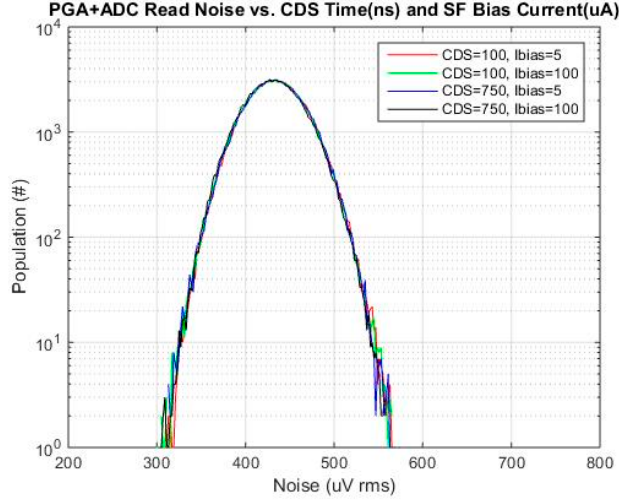
Figure 11. Base read noise histogram for selected t CDS and SF Ibias.